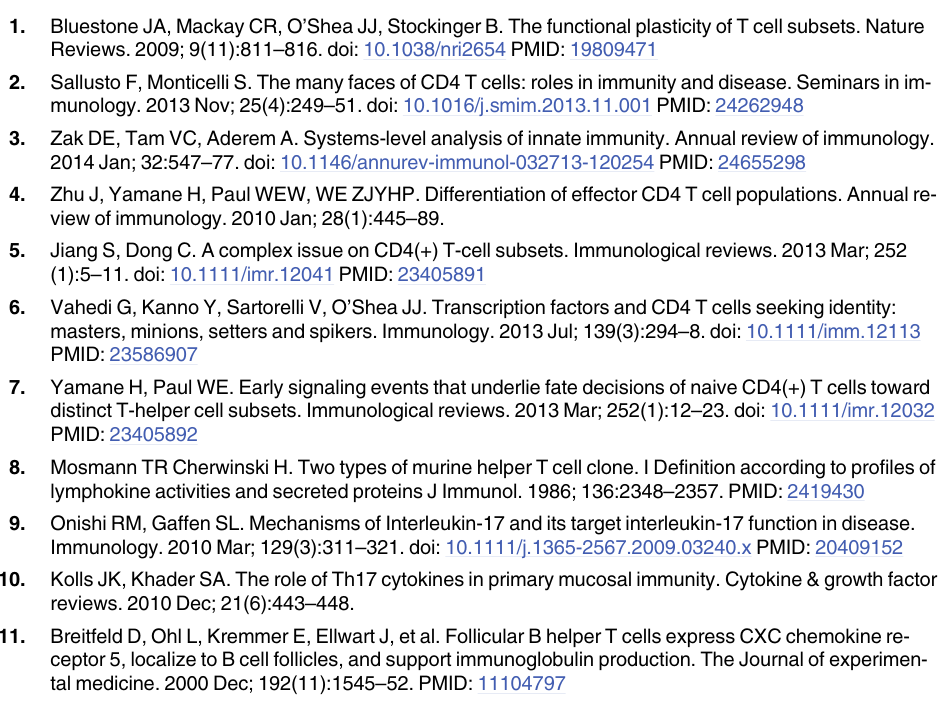
S4 Fig. Effect of transient perturbations on the state of the nodes of the T CD4+ lymphocyte transcriptional-signaling regulatory network. Number of transitions to an attractor in re- sponse to transient perturbations in the value of each node. The states of the node were per- turbed during one time step from 1 to 0 (-) or 0 to 1 (+), depending on its state in the original